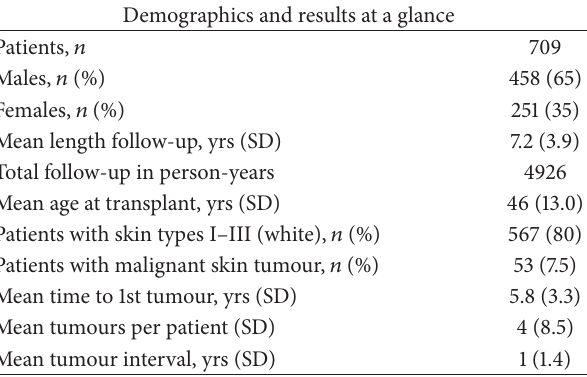
Table1:Patientdemographicdataandresultsataglance.Theresults showthemeanlengthoffollow-upfromtimeoftransplanttotimeof the most recent electronic entry to the patient’s record, the interval between tumours in those that developed at least two, and the mean number of tumours